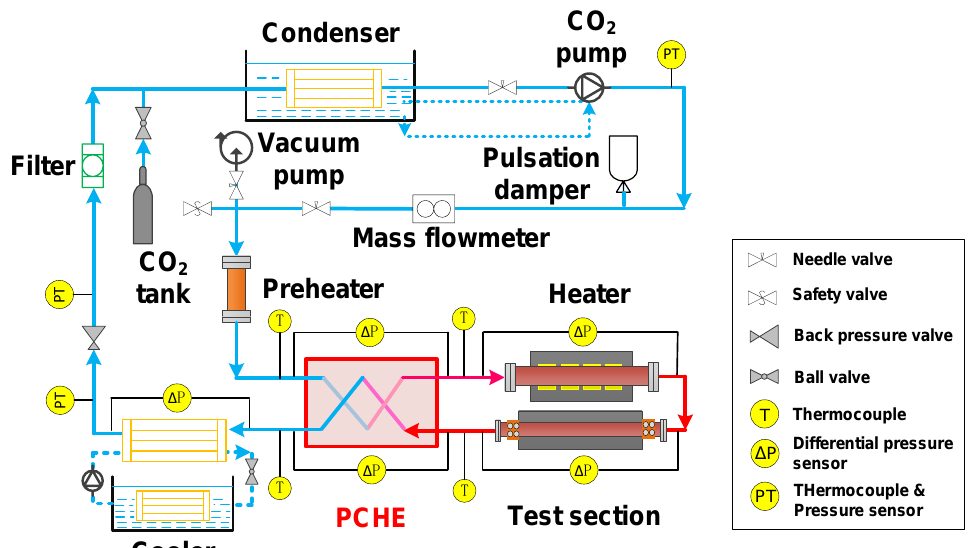
Figure 1. Schematic of the sCO 2 heat transfer and circulation test loop. The CO 2 from the tank is first cooled to the liquid state by the condenser and pres- surized to the working pressure by the CO 2 pump. The pulsation damper is installed at the pump outlet to reduce the flow fluctuations. The preheater helps the high-pressure liquid CO 2 cross the critical point and reach the steady inlet temperature for the PCHE test. Supercritical CO 2 absorbs heat on the cold side of the test PCHE prototype and then passes through the four-stage heater and the straight tube heat transfer test section in se- quence. The high-pressure and -temperature CO 2 returns to the hot side of the PCHE and heats the own medium on the cold side. The cooler after the PCHE hot outlet is for further cooling to protect the back pressure valve. Finally, the working CO 2 releases its pressure and returns to the condenser again for the next cycle. 2.2. Test PCHE Prototype The test trapezoidal PCHE prototype is shown in Figure 2, which is the main research object in this work. Trapezoidal channels with a 2 mm diameter semicircular cross-section are chemically etched on 316 L stainless-steel plates with a thickness of 1.50 mm. The pe- riod of the trapezoidal structure is 10 mm, the amplitude is 1 mm, the upper base length is 3 mm, and the base angle is 45 degrees, which are designed based on previous research results [25]. There are 20 channels on one plate, each of which has a length of 120 mm, including ten periods and two straight channel zones at both ends, and a 4 mm interval is left between two adjacent channels. The prototype has two hot plates and one cold plate, resulting in the mass flow of the hot channel being half of the cold side in each heat trans- fer unit to balance the flow velocity and heat capacity. Using diffusion bonding, the plates are combined into a 168 mm × 90 mm × 10.50 mm device with a 120 mm × 80 mm × 4.50 mm heat transfer core. The total heat transfer area is about 0.36 m 2 with a 0.30 m 2 area in the heat transfer core. Four 90 mm long pipes are welded on the top of the prototype and connected to the test loop by tube fittings.